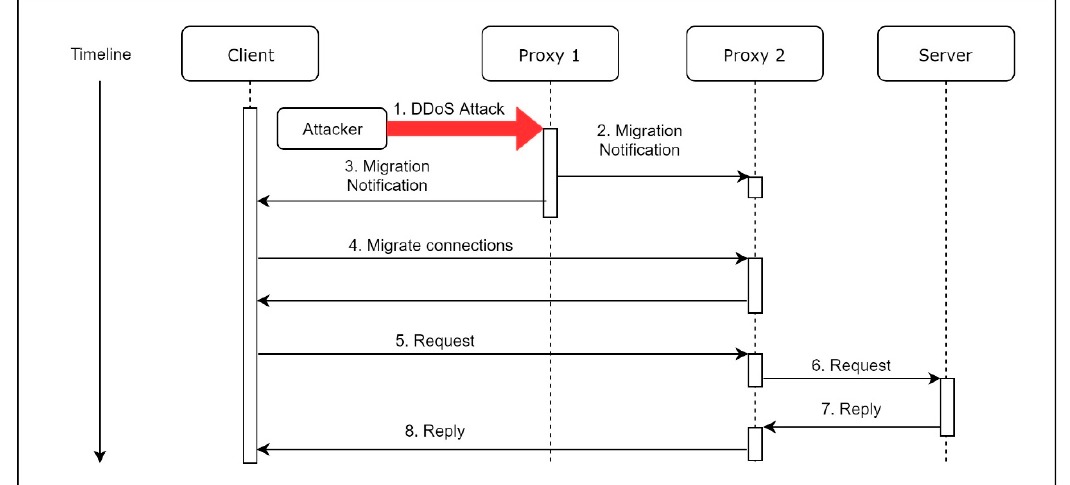
Figure 3. MVM workflow under distributed denial of service (DDoS) attack.